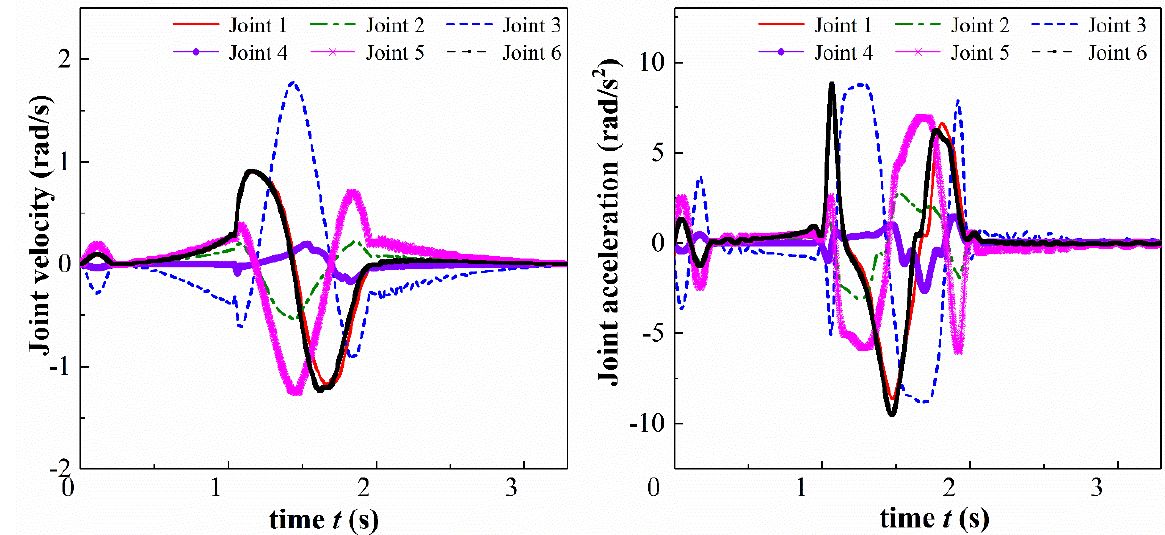
Figure 10. Experiment data of optimal trajectory with α = 10 0.4 .